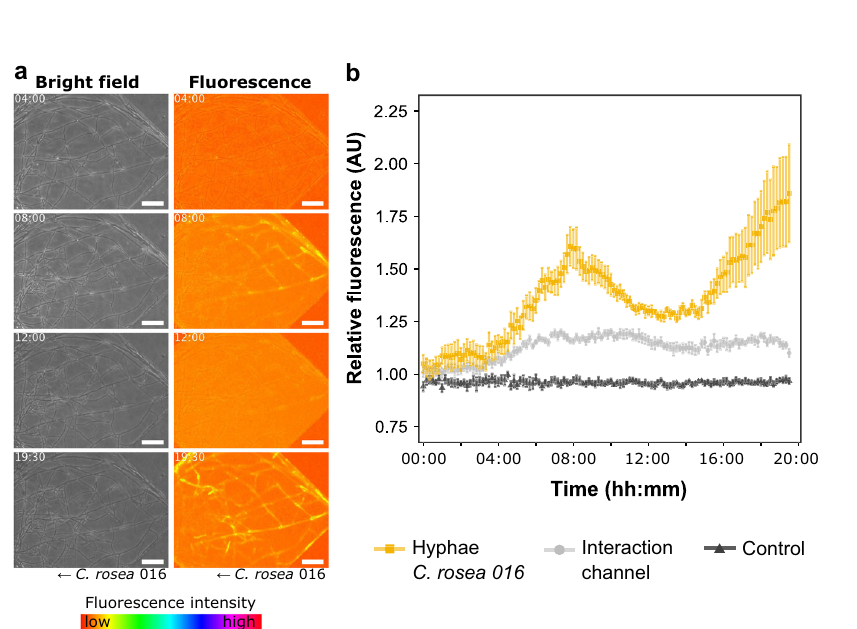
Fig. 3 Clonostachys rosea 016 antagonising Fusarium graminearum 8/1-wt-GFP within the fungal – fungal interaction device. a Series of phase contrast (bright- fi eld channel) and fl uorescence microscopy images taken from a time-lapse experiment (Supplementary Movie 2) showing continued growth of Clonostachys rosea around the pathogen Fusarium graminearum and the increasing loss of the green fl uorescence protein (GFP) detection from hyphae of GFP-expressing F. graminearum . The dashed box highlights the region of interest used for the preparation of Fig. 4. Scale bar = 200 µ m. b Time series showing the formation of hyphal branches by C. rosea that form contact with F. graminearum before the loss of fl uorescence. Scale bar = 25 µ m. c Relative fl uorescence intensities in arbitrary units (AU) over time. Error bars represent the standard error of the mean of six repetitive measurements. Hypha F = single hypha of F. graminearum in contact with C. rosea relative to the F. graminearum control channel. Interaction channel = fl uorescence intensity of the interaction channel relative to the F. graminearum control channel. Control = hyphae of F. graminearum not in direct contact with C. rosea relative to the F. graminearum control channel. d Time series showing septa formation by F. graminearum (red arrows) in response to hyphal contact with C. rosea . Scale bar = 10 µ m. Time stamp format = hh:mm.